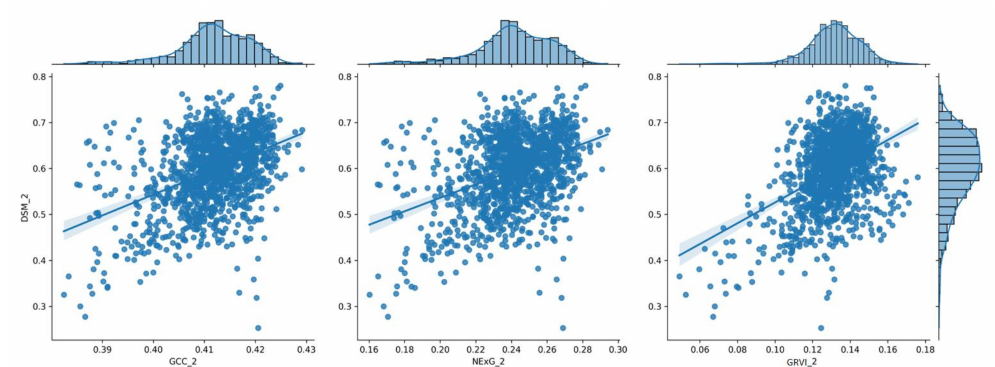
Figure 8. The distribution of the three (3) vegetation index values for the 2nd measurement (35 DAS), shown in a histogram in relation to the corresponding DSM